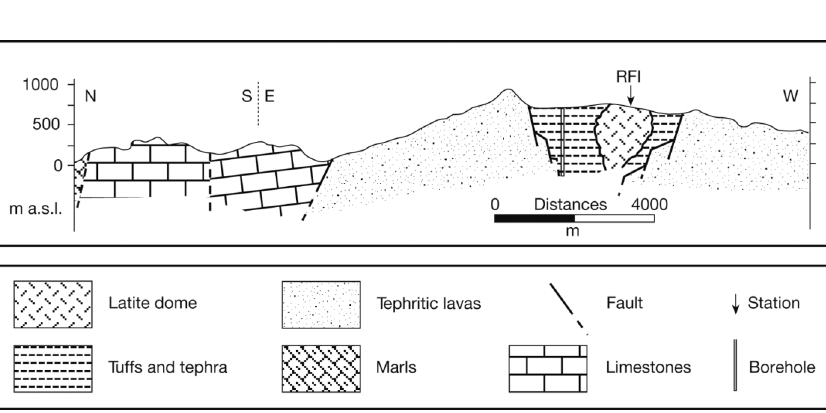
Fig. 8. Geological section at the site of the station RFI (Roccamonfina).